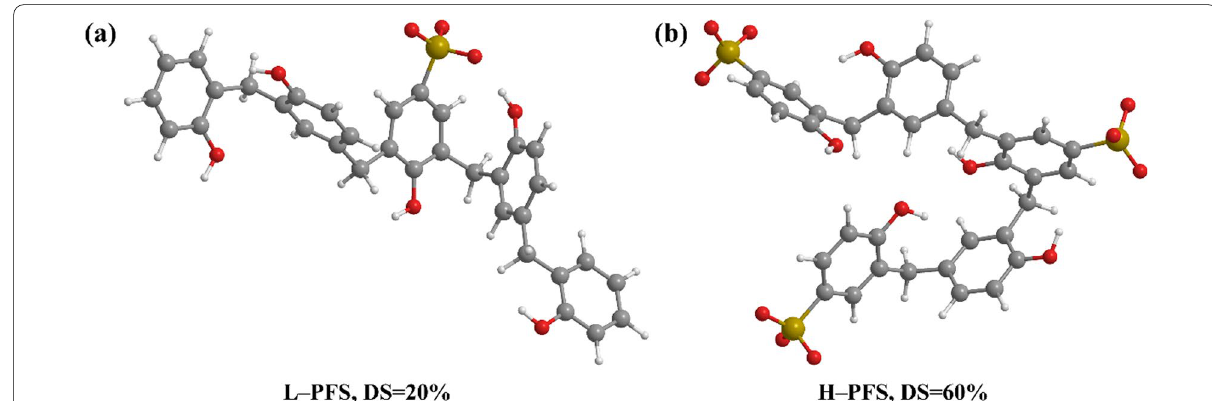
Fig. 2 Structures of L–PFS ( a ) and H–PFS ( b ) used in MD